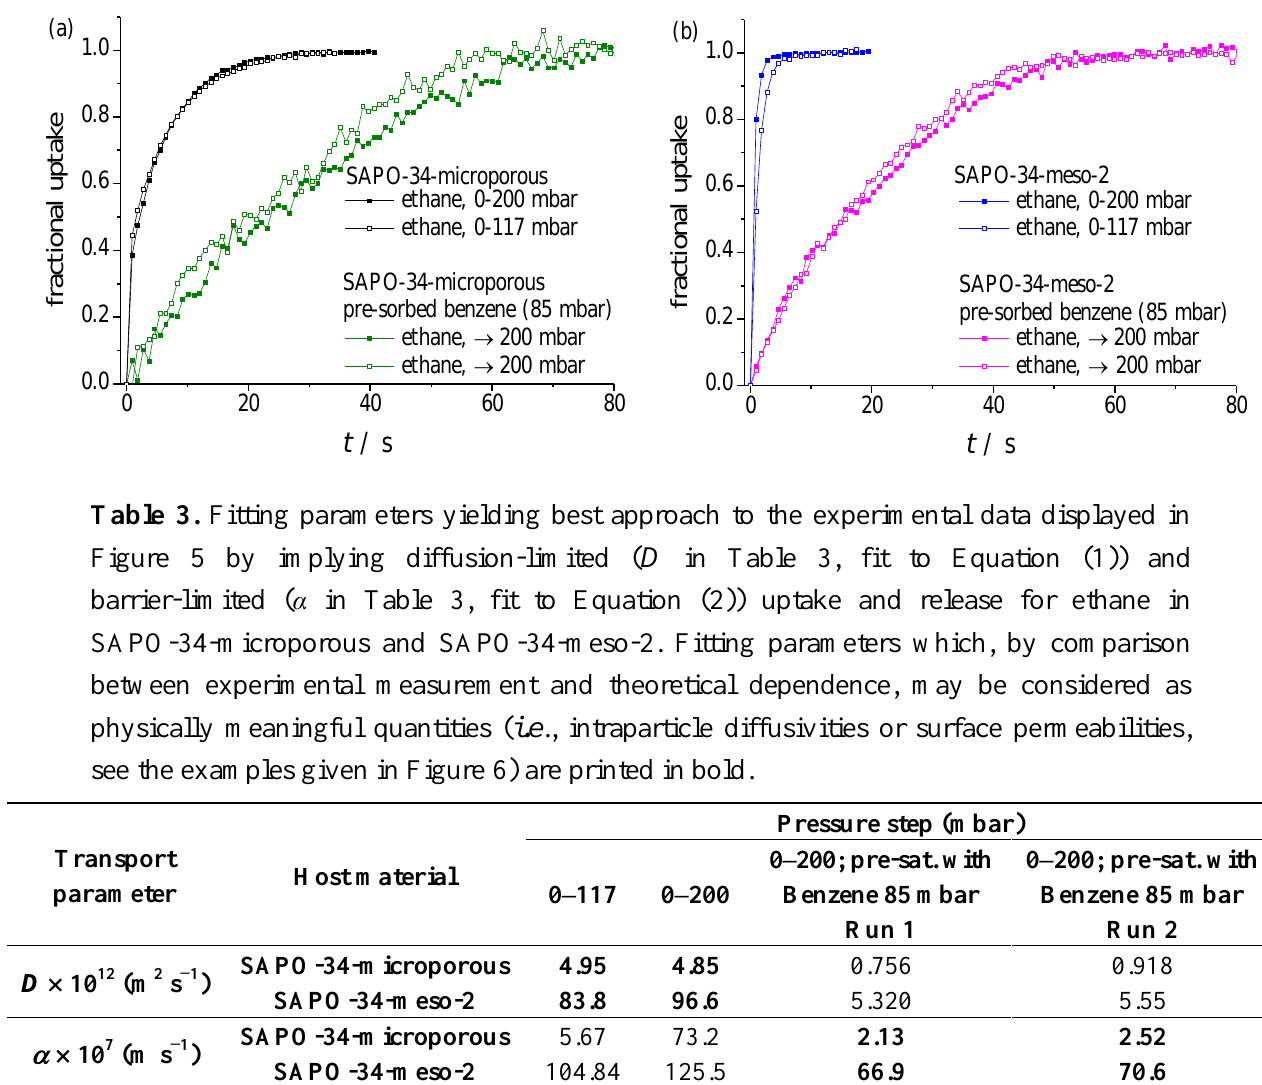
Figure 5. Uptake curves of ethane at 298 K in ( a ) SAPO-34-microporous; and ( b ) SAPO-34-meso-2. The black and blue curves represent the uptake curves for pure ethane using pressure steps of 0–200 mbar and 0–117 mbar, respectively. The green and magenta curves represent two runs of the following experiment: benzene is initially fed into the cell at a pressure of 85 mbar. Subsequently, a step increase in ethane pressure is produced so that the total pressure of the bulk phase increases to 200 mbar.